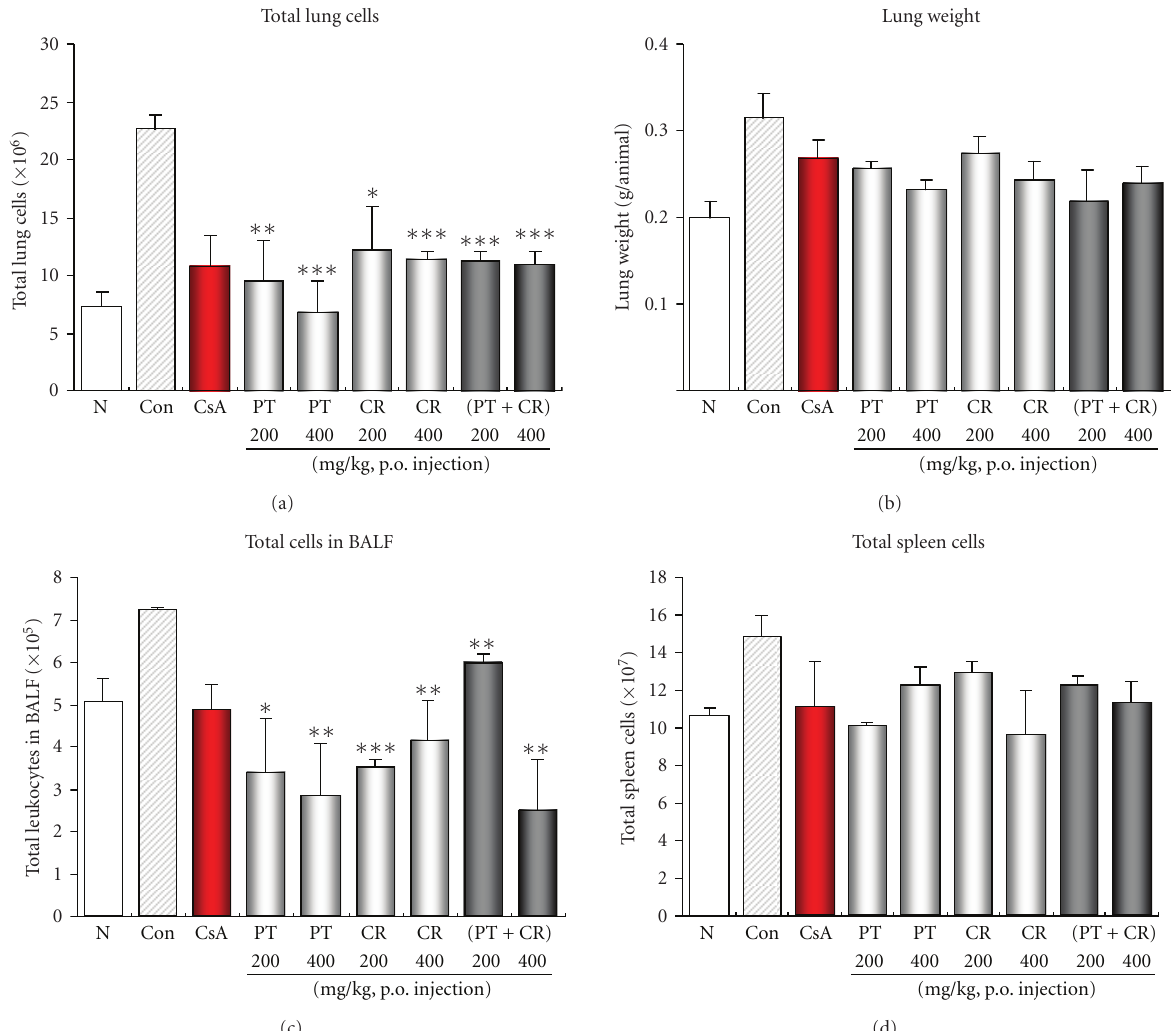
Figure 2: E ff ects of PT, CR and their combinational prescription on total lung cells, total leucocytes, total lung weight, and total spleen cell. Mice were processed as described in materials and methods, and whole blood was harvested 24 hours after the last OVA challenge. Total inflammatory cell numbers in BALF, lung and spleen were counted, and cell classification was performed on a minimum of 200 cells to classify lymphocytes. The results are expressed the mean ± S.E ( N = 5). Statistically significant value compared with control group data by ANOVA or unpaired Student’s t -test ( ∗ P < . 05, ∗∗ P < . 01, ∗∗∗ P < . 001). N: Normal Balb/c mice, CT: Ovalbumin inhalation (control group), CsA: OVA + CsA (10mg/kg), OVA + PT(200, 400mg/kg), OVA + CR(200, 400 mg/kg), OVA + (PT + CR) (200, 400